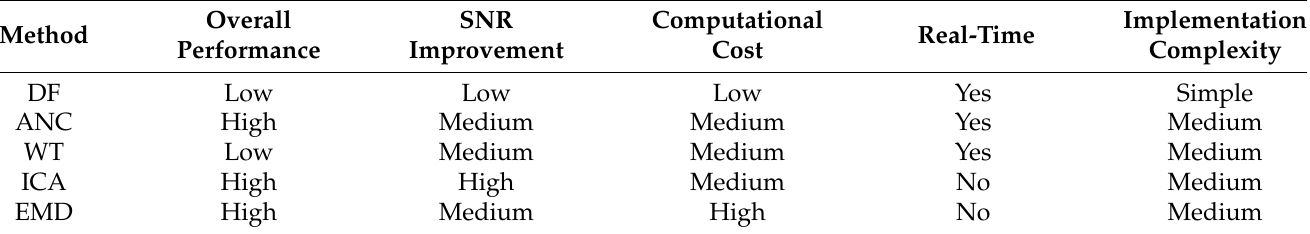
Table 2. Summary of the ENG signal processing